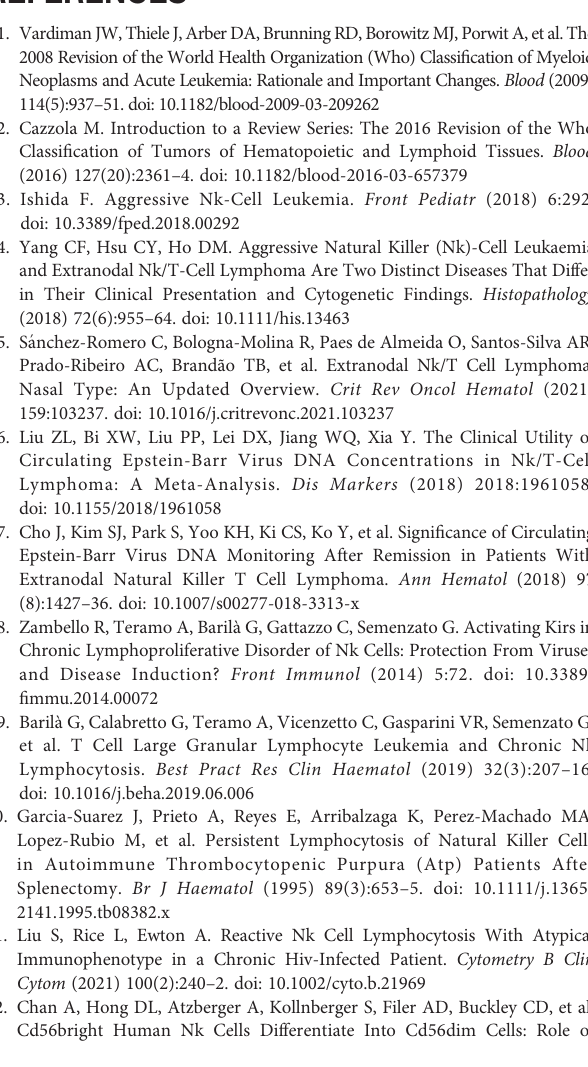
Supplementary Figure 1 | Speci fi c methods for de fi ning expression intensity. According tothe amountofexpression ofsurface markers,they can beclassi fi edas non-expressed, expressed, weakly expressed, and strongly expressed.